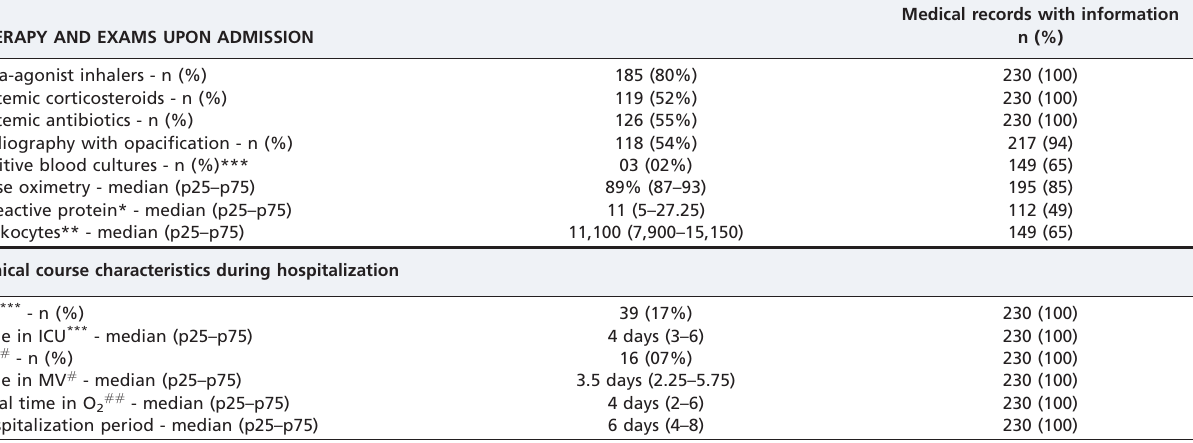
Table 1 - Description of the therapies prescribed and laboratory exams performed upon hospital admission and the characteristics of the clinical courses of the 230 patients included in the